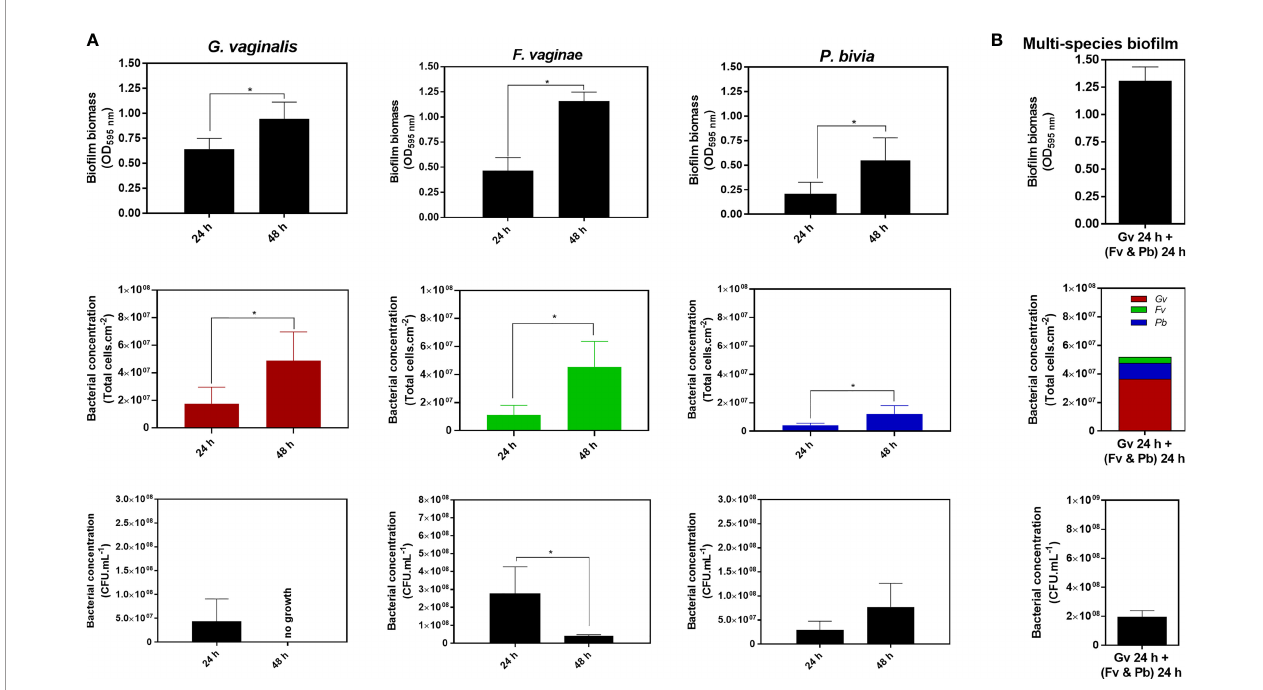
FIGURE 1 | Quanti fi cation of 24 h and 48 h single-species bio fi lms of G. vaginalis , F. vaginae and P. bivia (A) or a multi-species bio fi lm composed of all three species (B) using the crystal violet method, total cell counts by epi fl uorescence microscopy and the colony-forming units (CFU) method. The colors selected for the epi fl uorescence microscopy data re fl ect the fl uorophore detection spectra. Each data point represents the average ± s.d. of three experiments. *Values are signi fi cantly different between 24 h and 48 h of bio fi lm formation without changing the growth medium (batch system) (unpaired t-test, P <